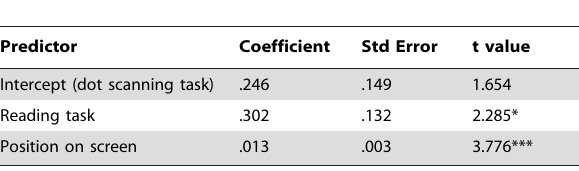
Table 4. Fixation disparity during reading and dot scanning experiments (for the subgroup of dyslexic children, n =6, who participated in Experiments 1 & 2): coefficients and standard errors are shown, and t-values with significance levels.